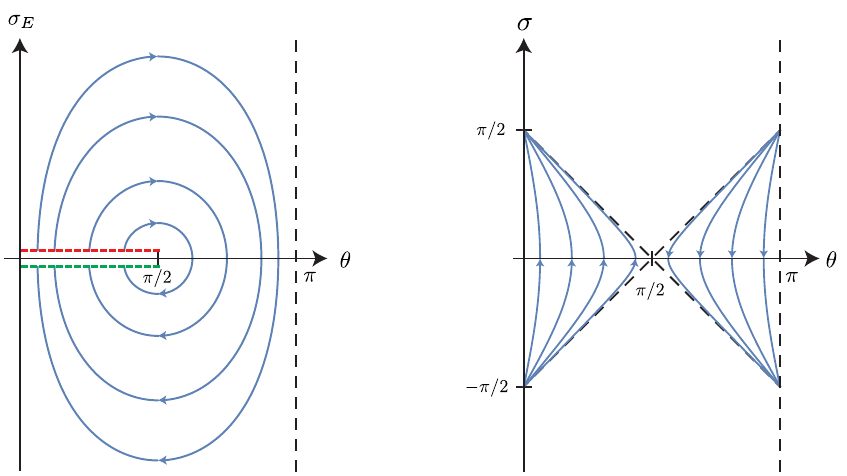
Figure 4 . On the left diagram we have the Euclidean (cid:13)ow generated by (2.14) applied on the surface at (cid:27) E = 0 + for (cid:28) 2 (0 ; 2 (cid:25) ). When we analytically continue to Lorentzian time (cid:27) E = i(cid:27) we obtain the (cid:13)ow on the right